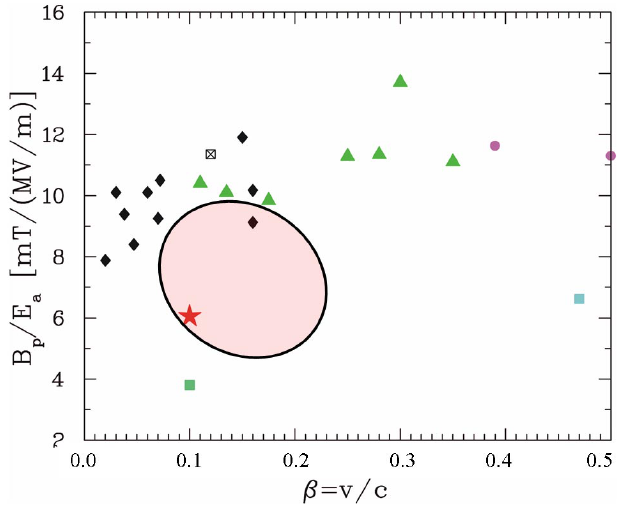
=E of the magnetic peak field and p a